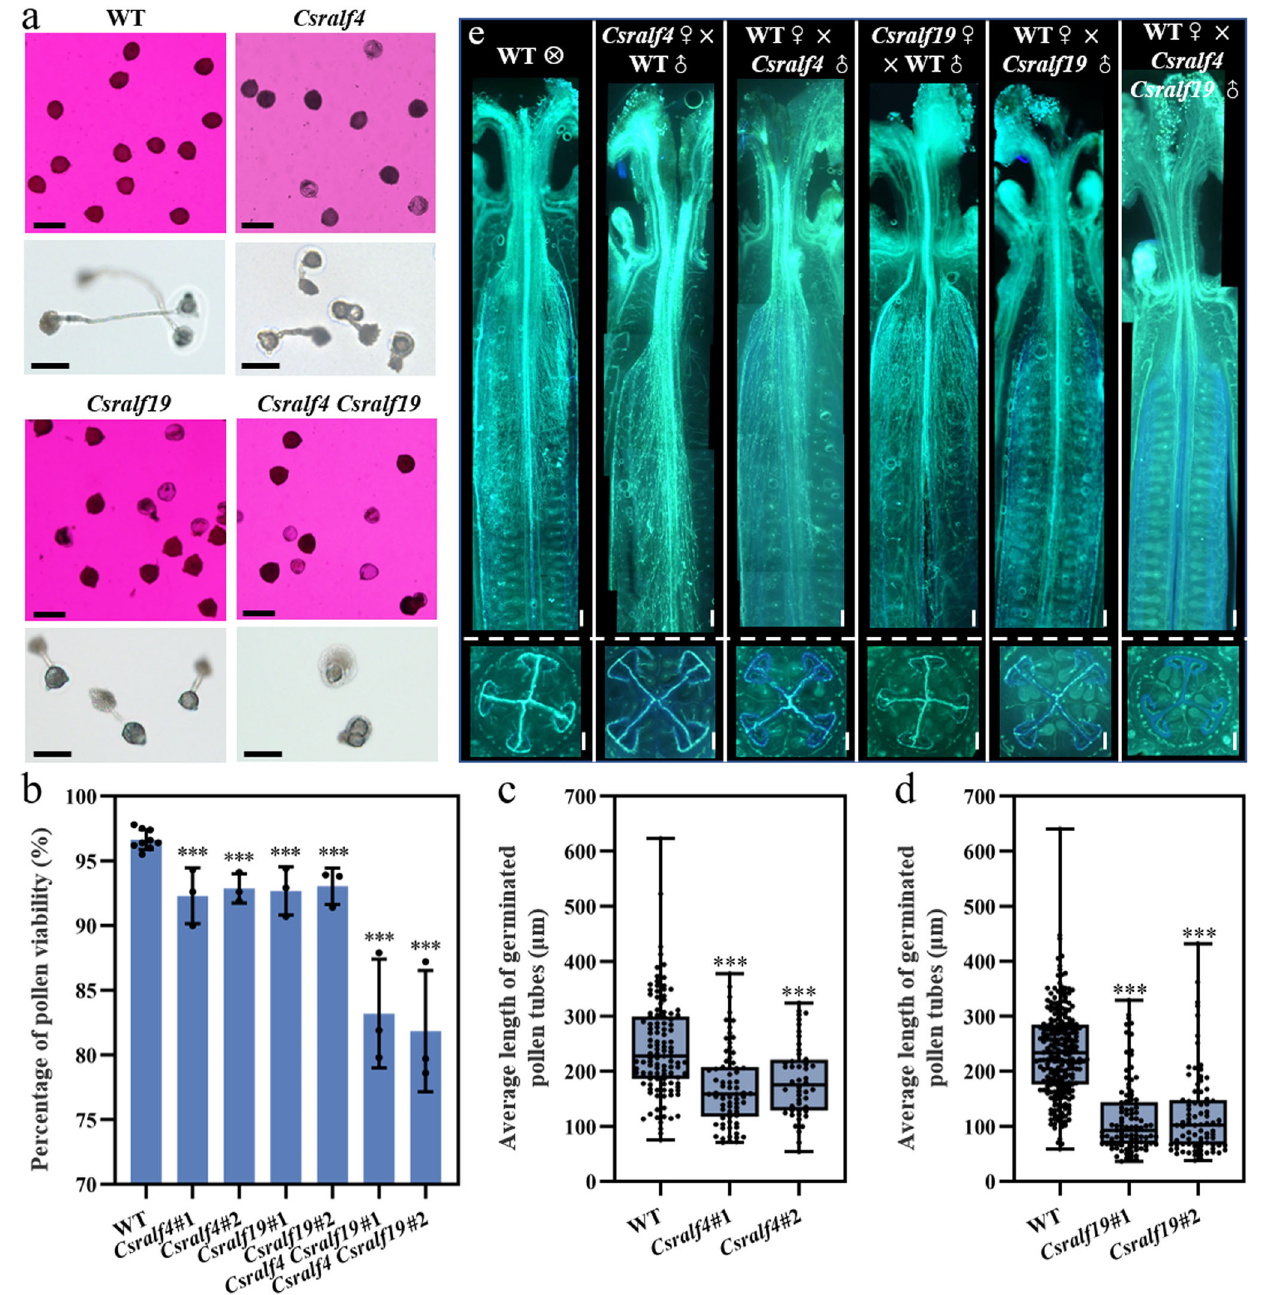
Fig. 6 | Abolishedmalefertility in Csralf4Csralf19 doublemutants.a Alexander staining of pollens (top row) and in vitro pollen germination assay (bottom row) of Csralf4 , Csralf19 and Csralf4Csralf19 mutants.Scalebars=100 μ m. b – d Quantitative analysisofpollenviability( b )andpollentubeslength( c , d )from( a ). n =9,3,3,3,3, 3,3biologicallyindependentsamplesin( b ).Errorbarsrepresentmean±SD.n=115, 71,48pollentubesin( c )and240,97,83pollentubesin( d ),respectively.*** p <0.001